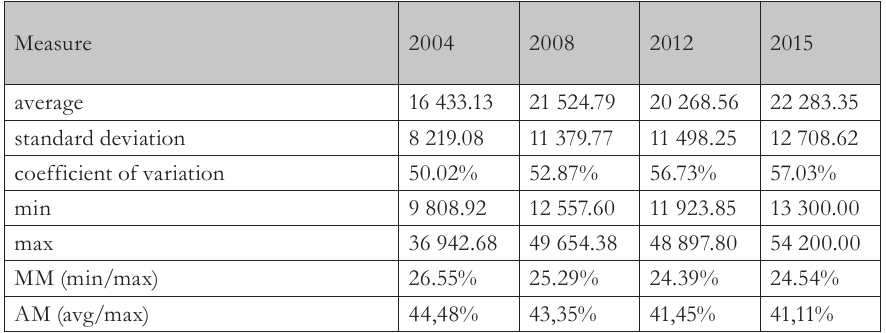
Tab. 6 – Selected measures describing the level of the regional GDP pc level and its diversifica- tion in Slovakia in selected years [data in EUR according to PPS (2015=100)]. Source: Own calculations based on Eurostat database (access: